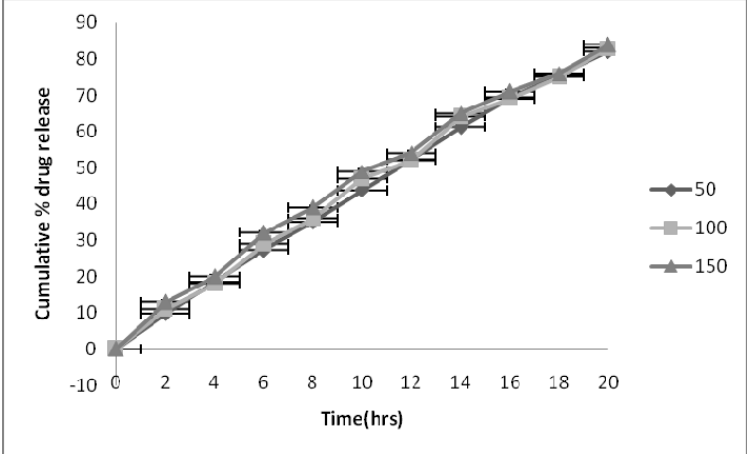
Figure 4. Effect of stirring rate on drug release from optimized